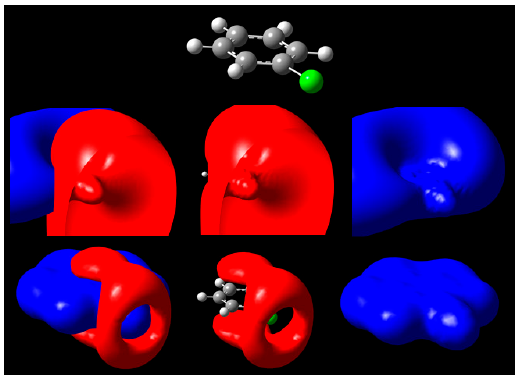
Figure 3. Isopotential surfaces of PhCl, separated between negative (red) and positive (blue) regions. Isopotential pairs are ±0.03 (second row) and ±0.3 V (bottom). A molecule is depicted for position reference.